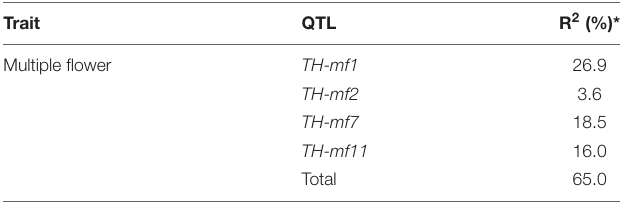
TABLE 4 | Cumulative effect of all QTLs detected for the multiple-flower-per-node trait in TH